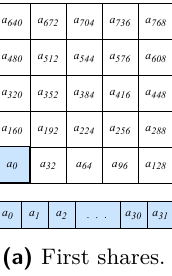
Figure 6: Placement of the first (left) and second (right) shares represented as matrices of 5 × 5 lanes. The first 32-bit lane of each share is detailed in the lower part of the figure with their respective (shifted) bit indices. The first share is denoted by a and the second by b where we use subscript to indicate the separate